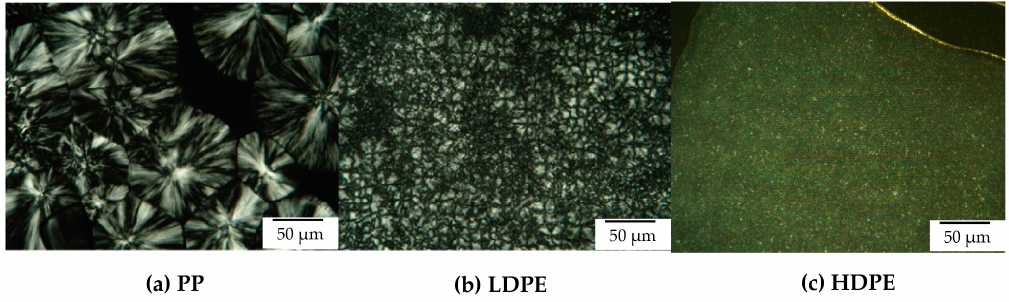
Figure 4. Polarizing optical microscopy of ( a ) LDPE after isothermal crystallization at 100 °C for 20 min, and ( b ) PP after isothermal crystallization at 125 °C for 20 min and ( c ) HDPE after isothermal crystallization at 124 °C.